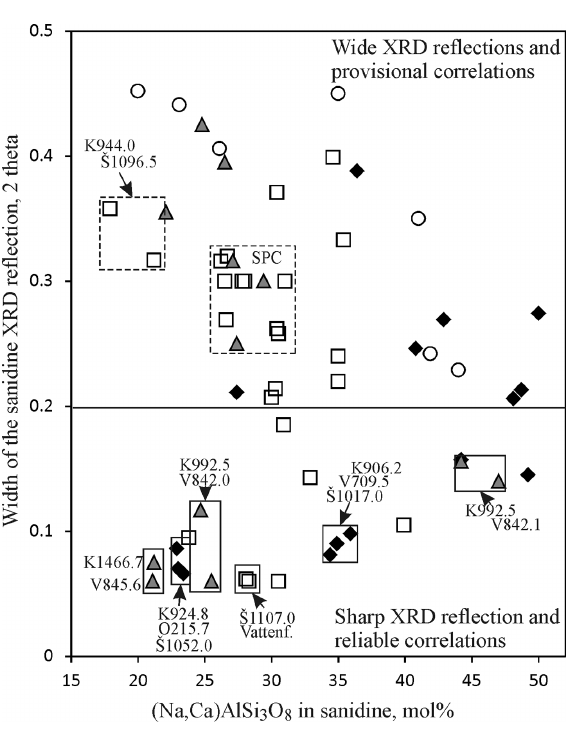
Fig. 2. Results of XRD measurements of sanidine composition on the binary chart: composition versus width of the XRD reflection. Width of the XRD reflection indicates homogeneity (sharp reflection) and heterogeneity (wide reflections) of sanidine crystals. Solid frames denote reliable correlations, broken line frames provisional correlations. K, Kurtuv ė nai; (cid:138), (cid:138)iupyliai; V, Ventspils; O, Ohesaare; Vattenf., Vattenfallet; SPC, several provisional correlations. Empty rings mark Aeronian, grey triangles (cid:150) Telychian, empty quadrangles (cid:150) Sheinwoodian, black diamonds (cid:150) Homerian. Thirteen studied samples from Lithuania are absent from this figure, as they did not contain sanidine.